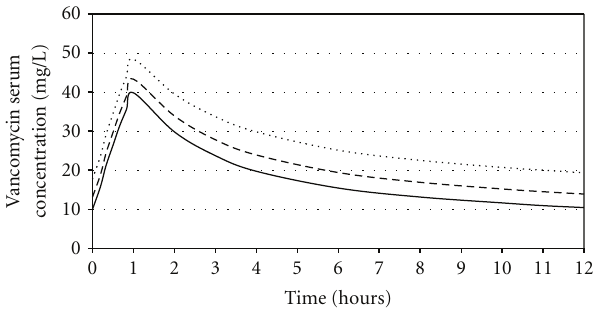
Figure 6: Simulation of steady-state vancomycin serum concentra- tion profile in the 50-year-old patient using dosage regimen of 1 gram/12